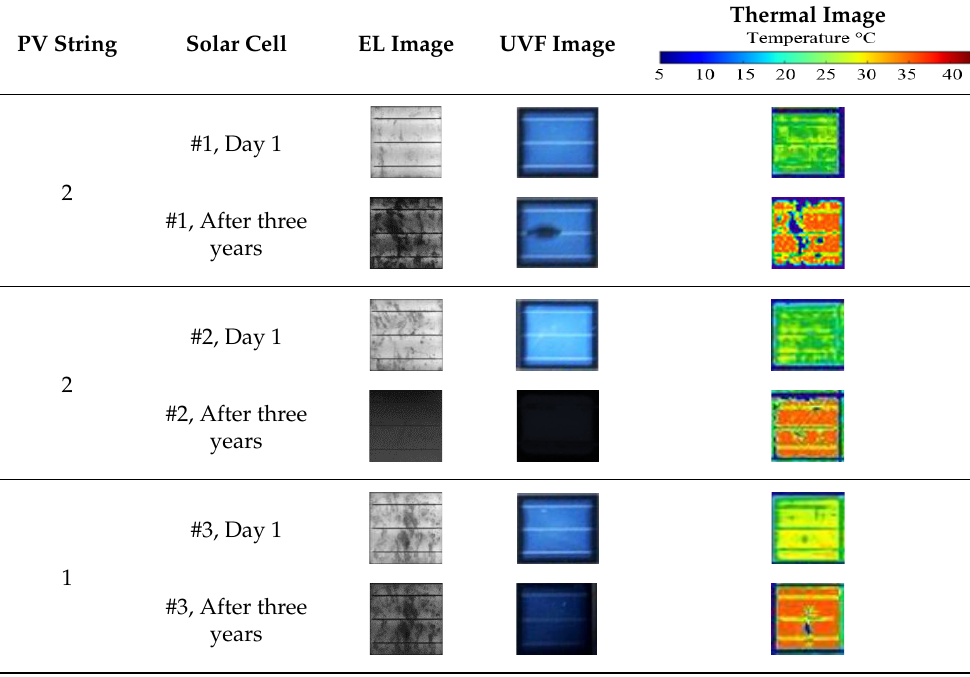
Figure 10. Thermal images of the tested PV strings after three years of field operation, taken under 830 W/m 2 solar irradiance and a PV surface temperature of 23.3 °C: ( a ) PV string 1, ( b ) PV string 2.